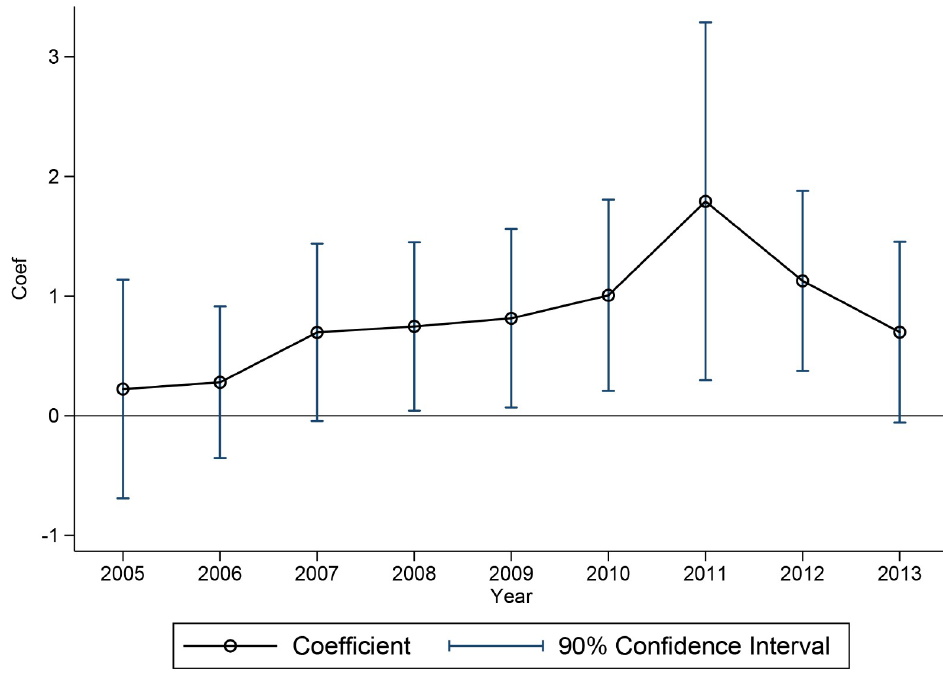
Fig 1. Parallel trend test coefficient